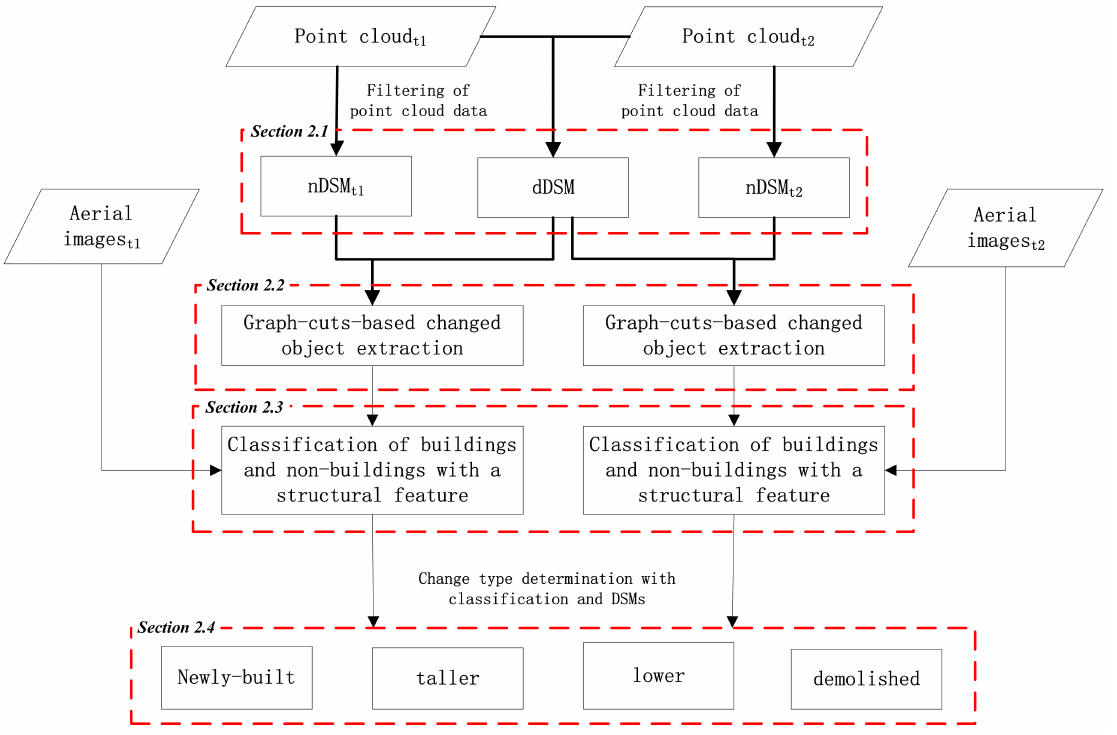
Figure 1. Workflow of the proposed algorithm for building change detection from dense-matching point clouds and aerial